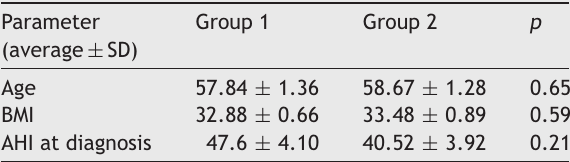
Comparison of demographic data between patients in Group 1 (good adherence to CPAP) and of